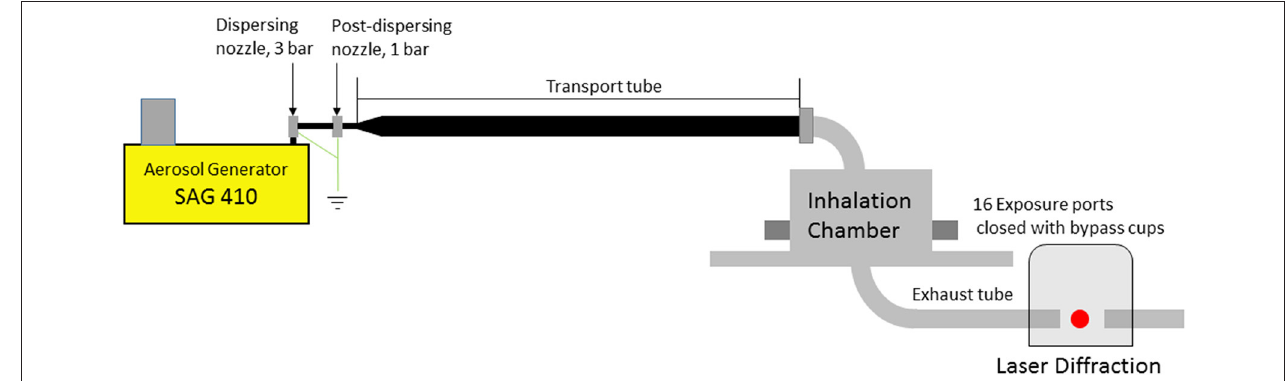
FIGURE 2 | Test set-up for simulating inhalation experiments: aerosol generator and inhalation system, consisting of transport tube and inhalation chamber; laser diffraction particle sensor.